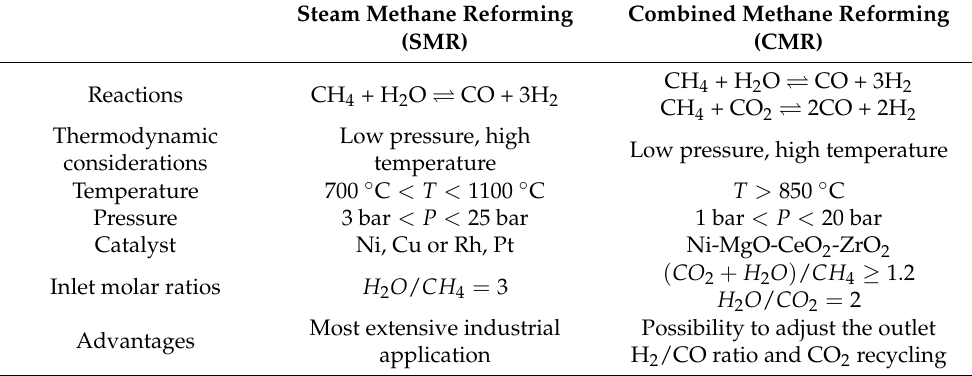
Table 4. Comparison of the most suitable syngas generation technologies for the COG utilization. Steam Methane